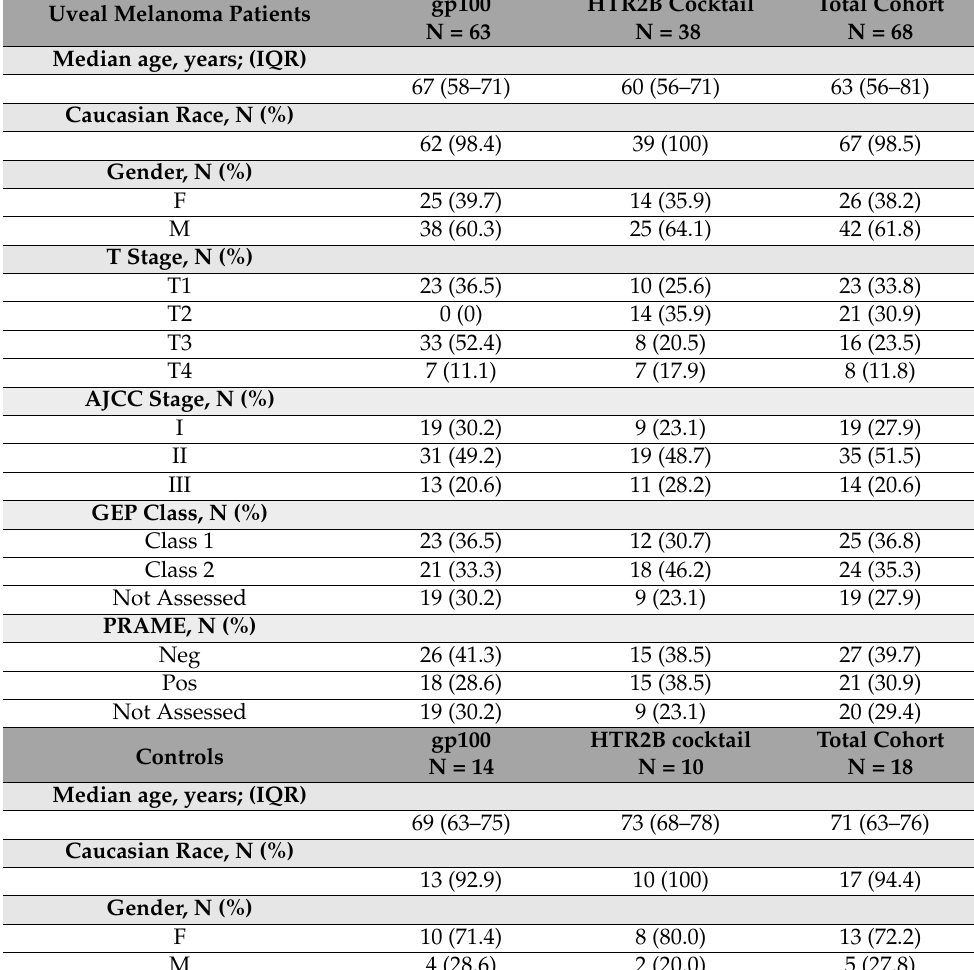
Table 1. Clinicopathologic Characteristics of Subjects Analyzed. Uveal Melanoma